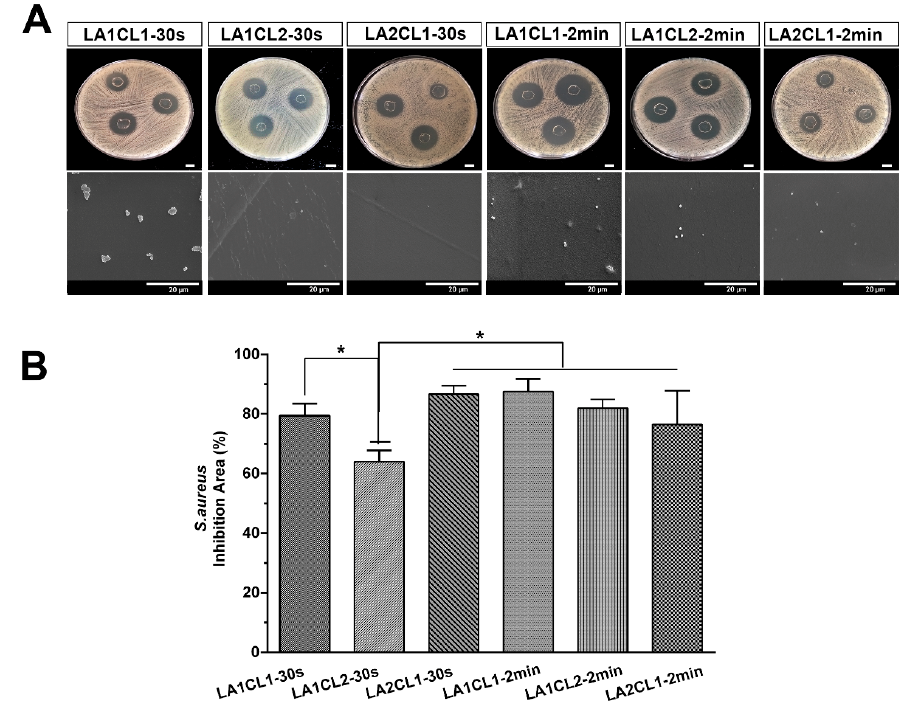
Figure 10. Assessment of antimicrobial profile of the photocrosslinked films against S. aureus . ( A ) Macroscopic images of the inhibitory halos. ( B ) Relative value of the inhibition area presented by the films. Data are presented as the mean ± standard deviation, n = 3, * p < 0.05.